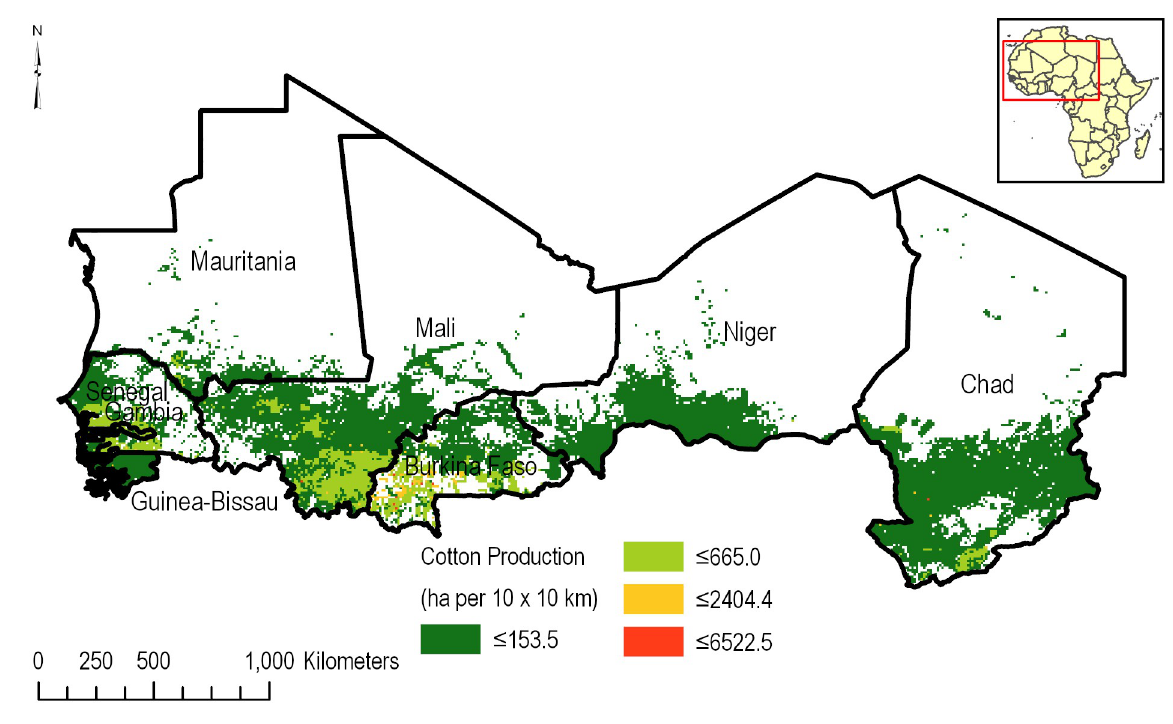
Fig 4. Distribution of cotton production in the CILSS based on the 10 km x 10 km mapSPAM [9] data.